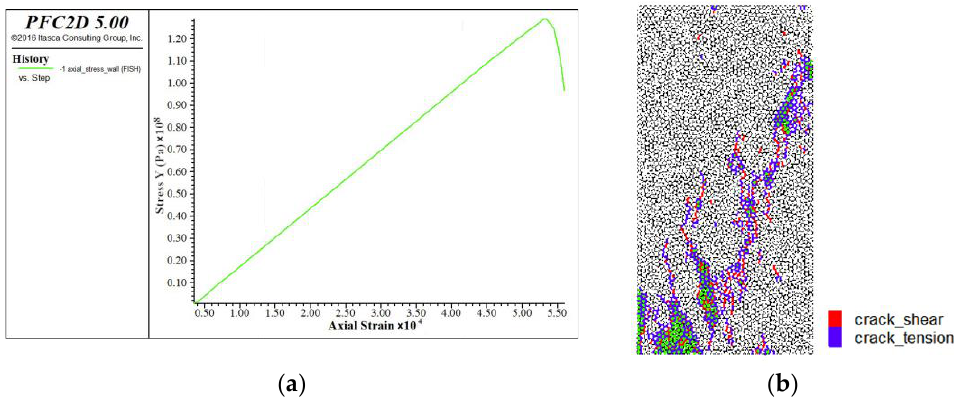
Figure 10. Uniaxial compression Poisson’s ratio parameter calibration, ( a ) curve figure, ( b ) failure mode.